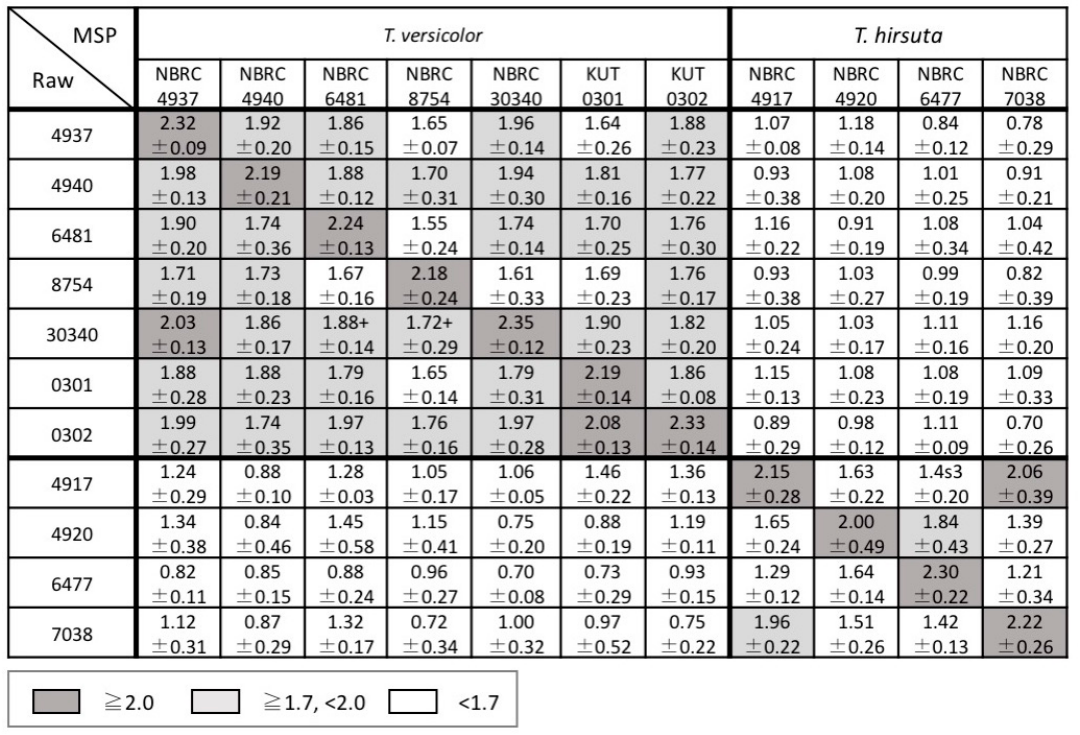
Figure 6. Average identification scores of raw mass spectra and the MSPs of Trametes . The scores presented are between 0 and 3: ≥ 2.0 (gray cells) was accepted for reliable identification to the species level; ≥ 1.7 and < 2.0 (light gray cells) was accepted for identification to the genus level; and < 1.7 (white cells) indicated unreliable identification of fungi.